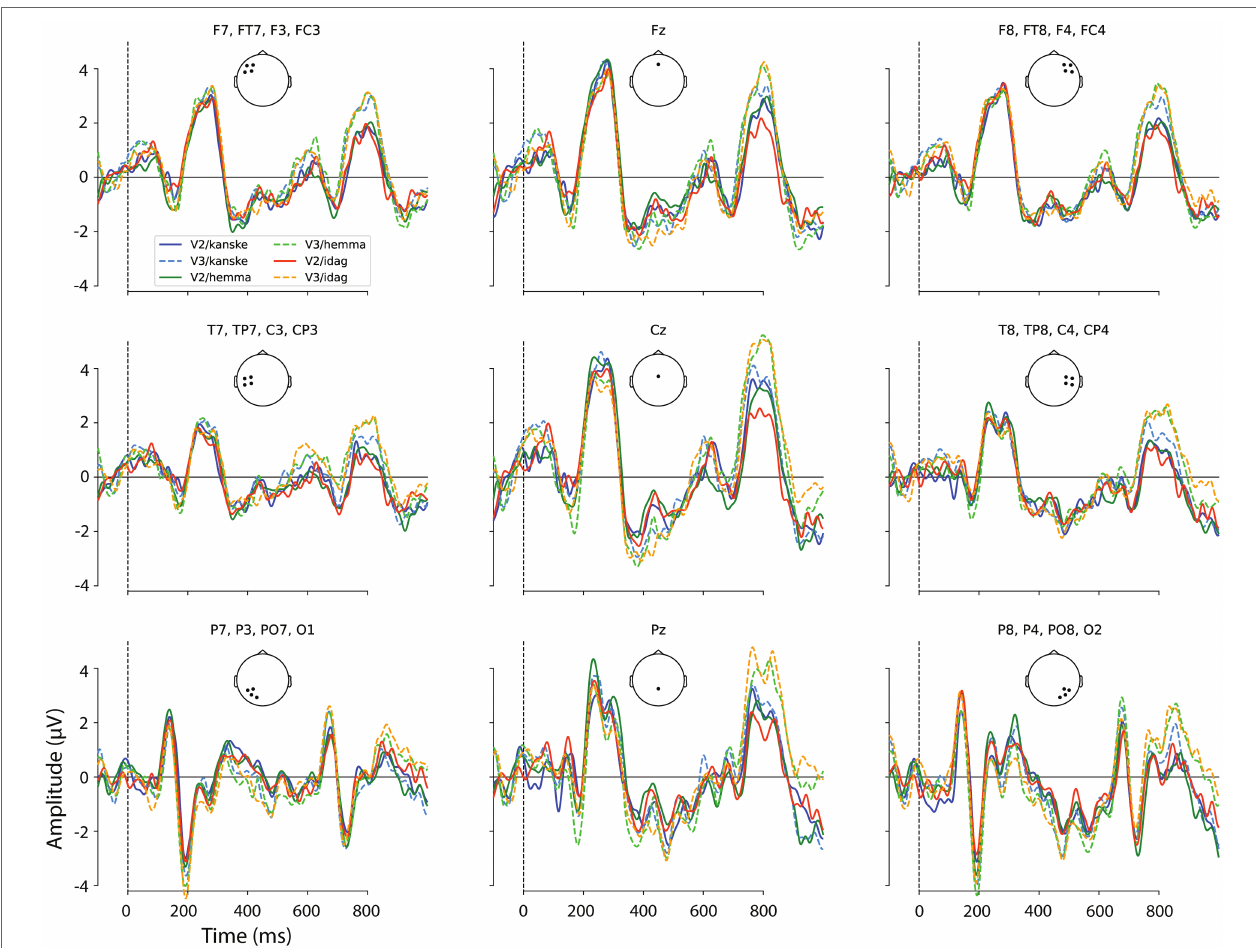
FIGURE 2 | Grand average waveforms, the ERPs to V2 word order (full lines) and V3 word order (dotted lines) for each adverbial at the nine ROIs. ERPs to subjects in V2 and V3 following hemma in green, idag in red and kanske in blue. Positive plotted